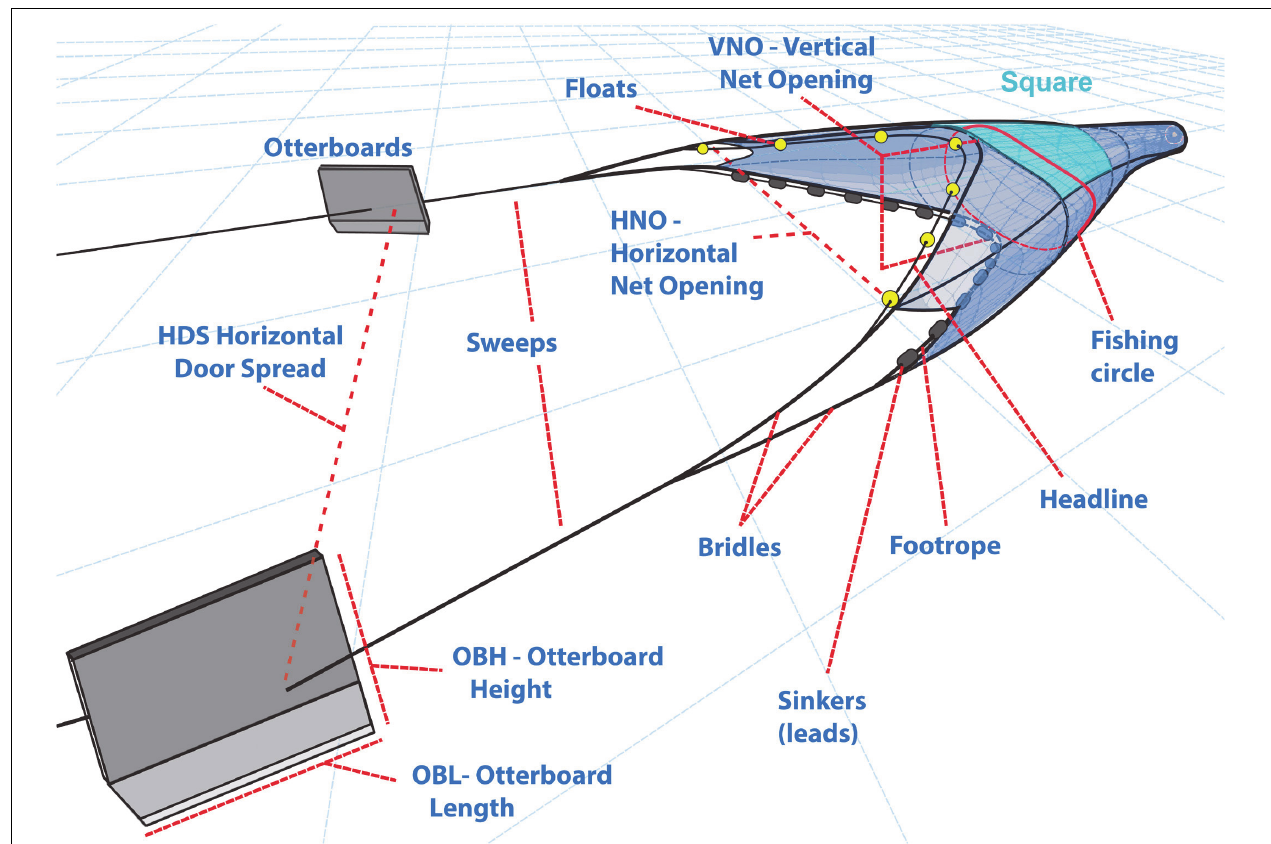
FIGURE 1 | Schematic representation of the main gear-metrics and otterboard’s descriptors